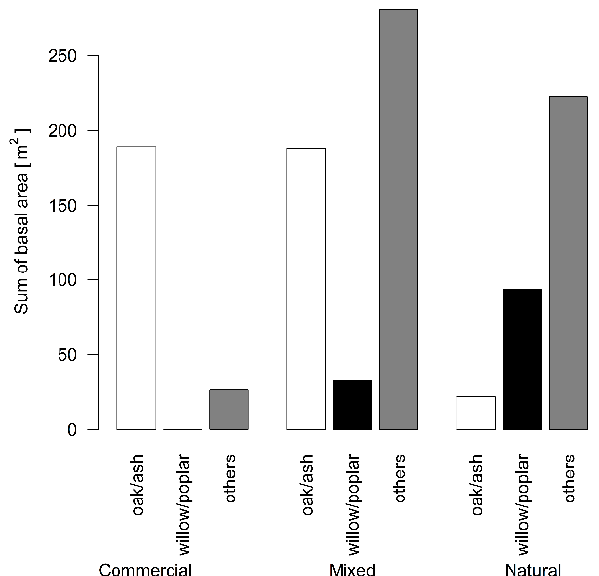
Figure A1. Proportion of groups of woody plant specimens in different types of forest stands. The sum of basal area (m 2 ) of commercial woody plants—oak ( Quercus ) and ash ( Fraxinus ); non-commercial soft woody plants—willow ( Salix ) and poplar ( Populus ); and non-commercial other woody plants in three types of forest stands: monoculture, mixed, and natural.